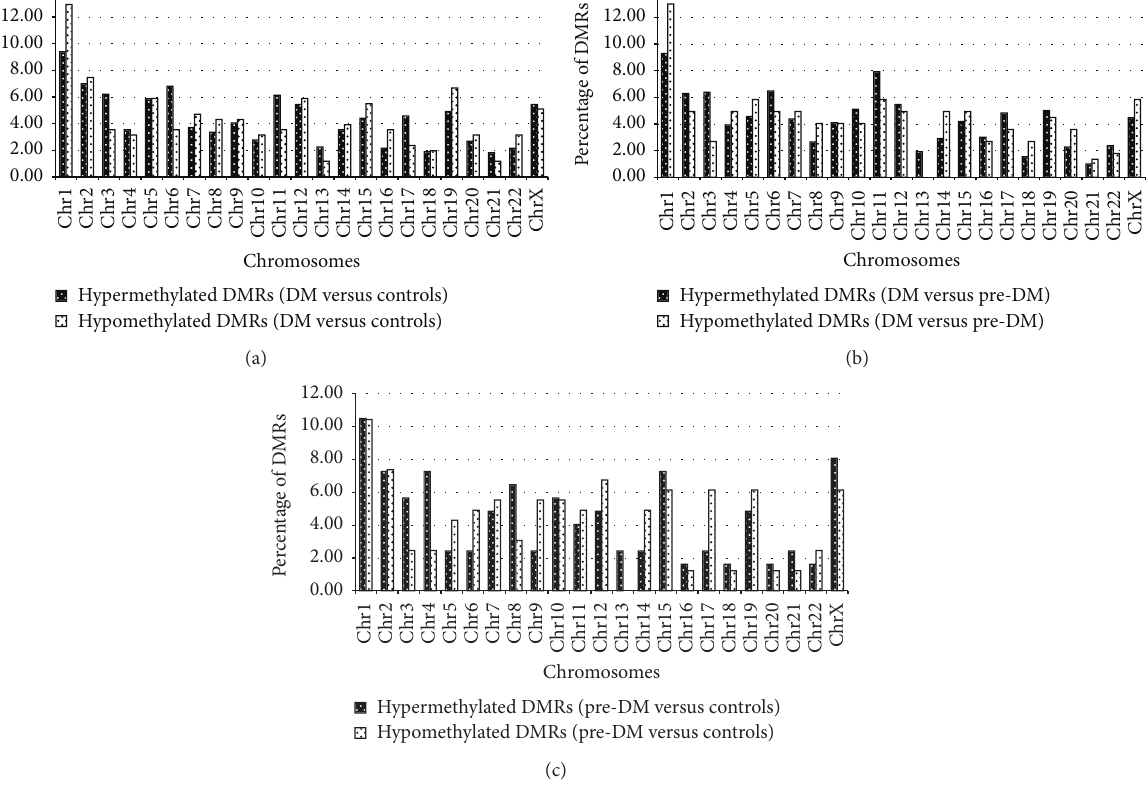
Figure 2: Accumulation of differentially methylated regions (DMRs) in chromosomes. (a) represents DMRs in diabetes versus controls, (b) represents DMRs in diabetes versus prediabetes, and (c) represents DMRs in prediabetes versus